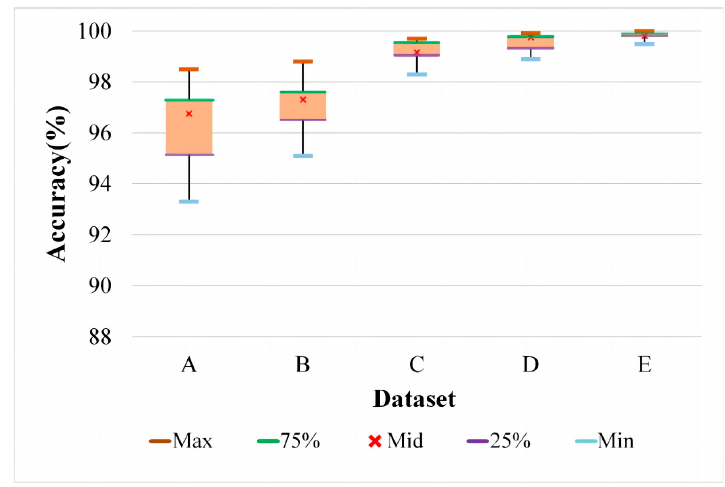
Figure 15. Experiment results with different numbers of generated samples. Table 6. Experiment components with different amounts of generated samples.